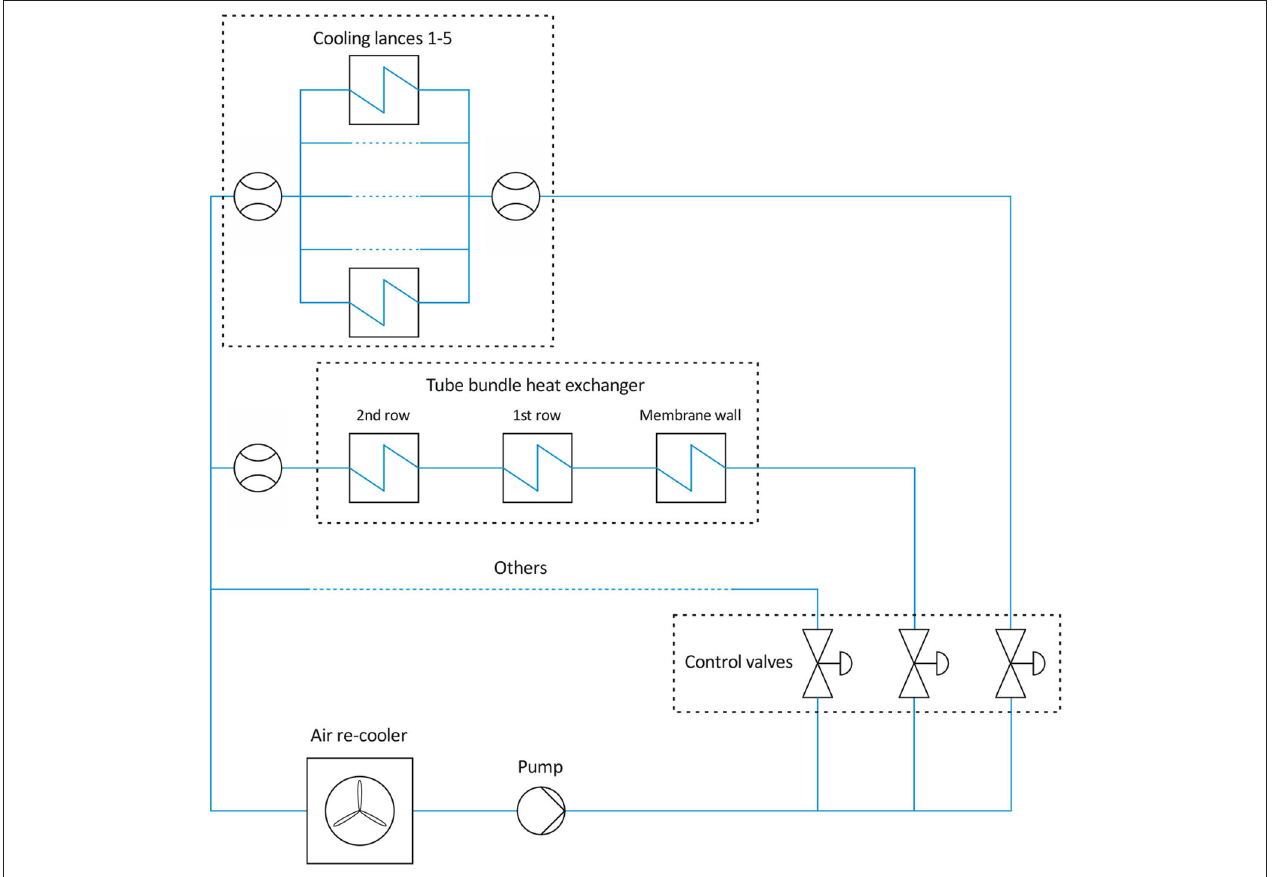
FIGURE 2 | Flow diagram of the cooling system (water